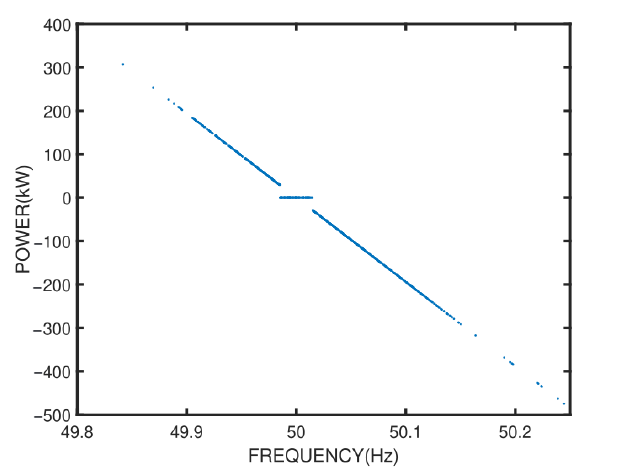
Figure 6. DFFR of envelope showing power vs. frequency